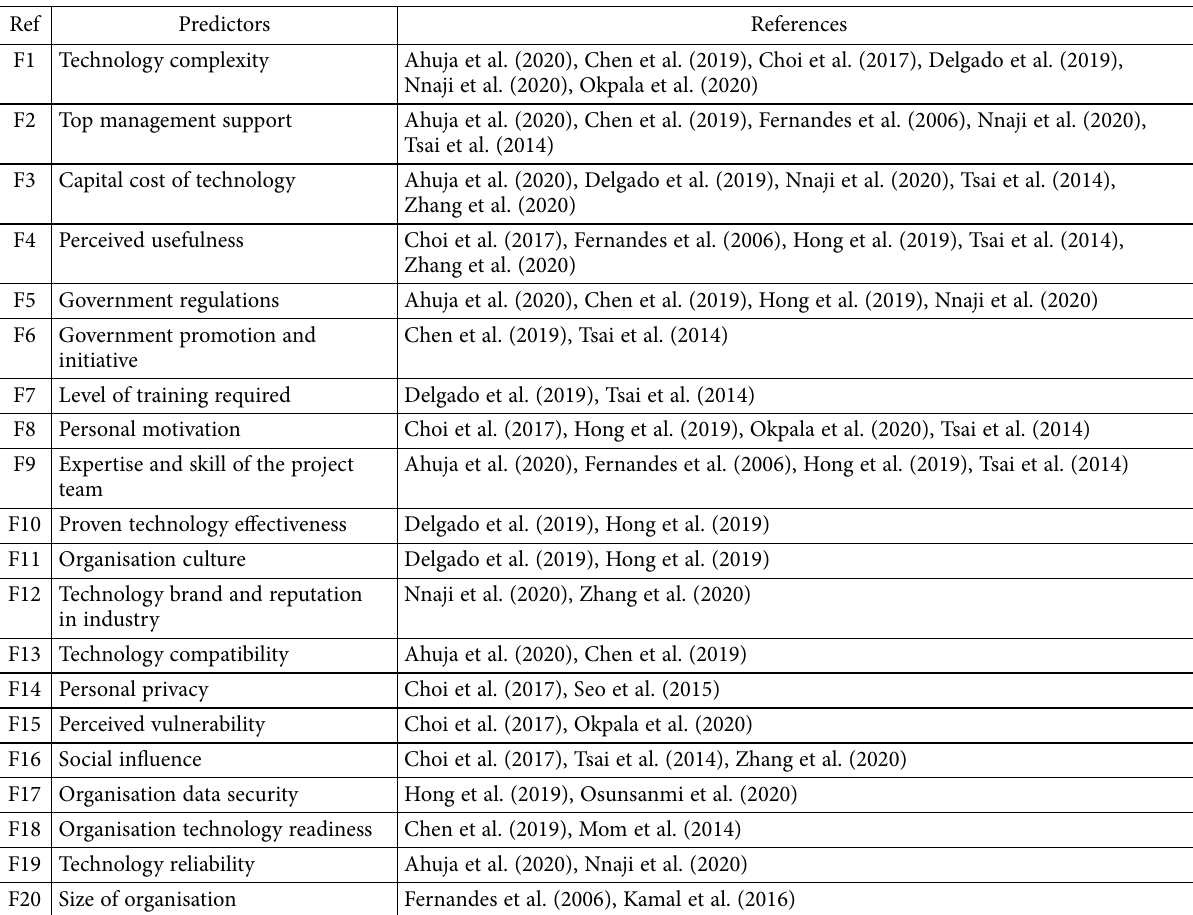
Table 1. Summary of predictors of safety technologies adoption in construction